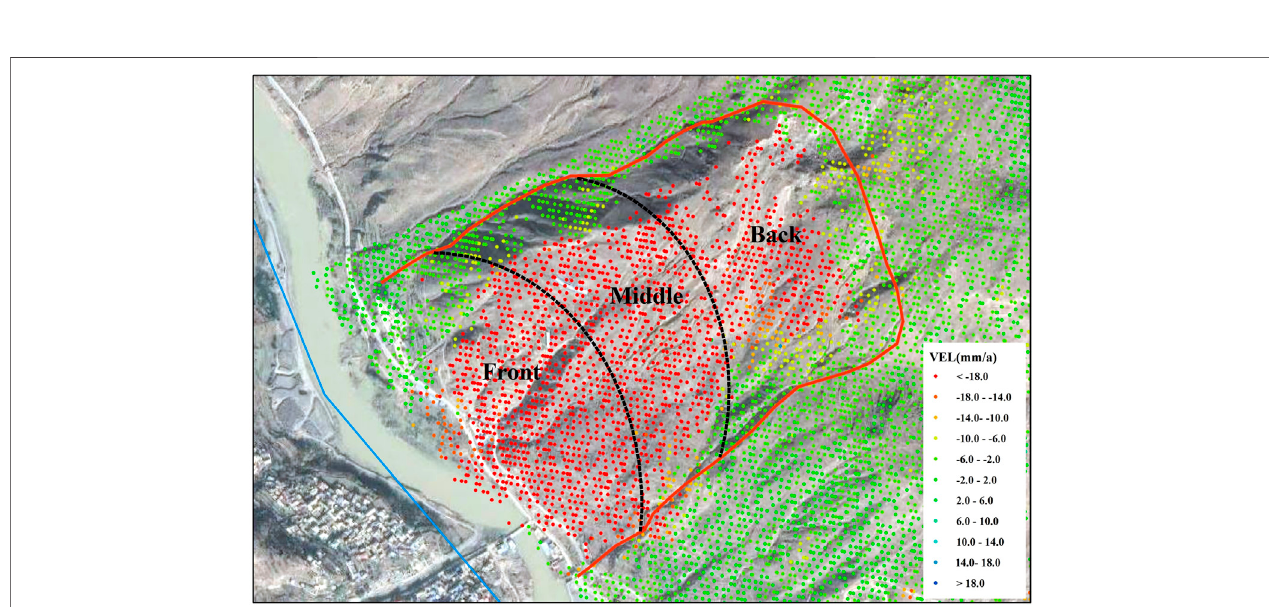
FIGURE 11 | Motion direction map of Nanyu landslide.